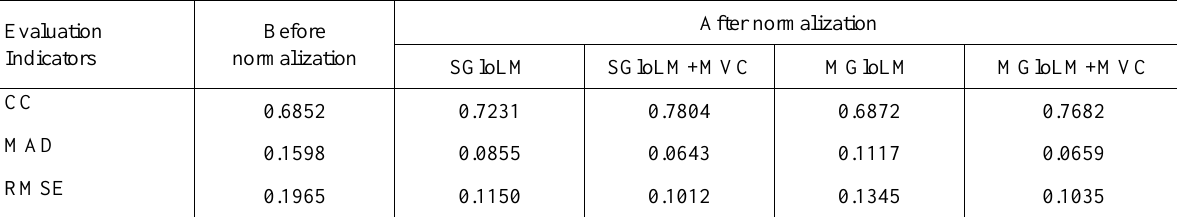
Table 2 . Quantitative evaluation of normalized